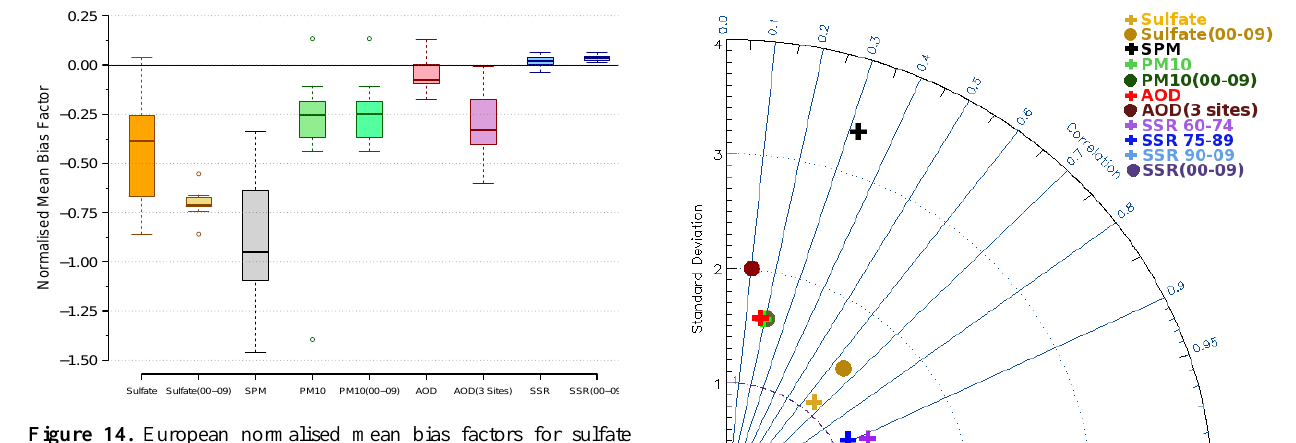
Figure 14. European normalised mean bias factors for sulfate aerosol mass, SPM mass, PM 10 mass, AOD and SSR across all the years where data were available (see Tables 2–5) and separately for the period 2000–2009. The solid line shows the median value, the boxes show the 25th and 75th percentile values with the error bars showing the maximum and minimum values and the circles repre- senting outliers (values > 1.5 × interquartile range).